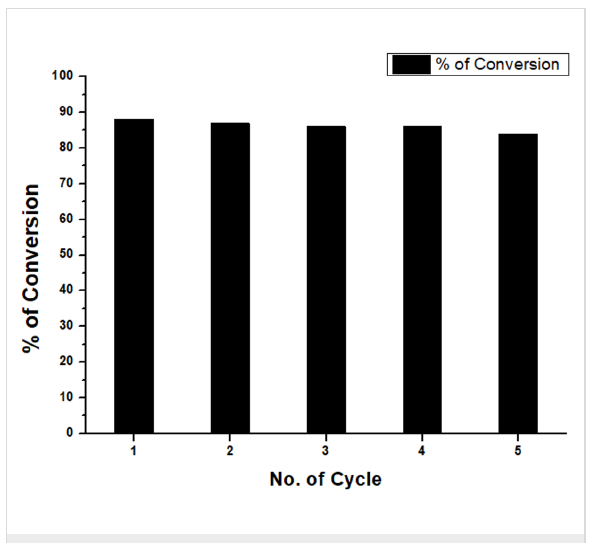
Figure 7: Recycling experiment of the Ni–chitosan